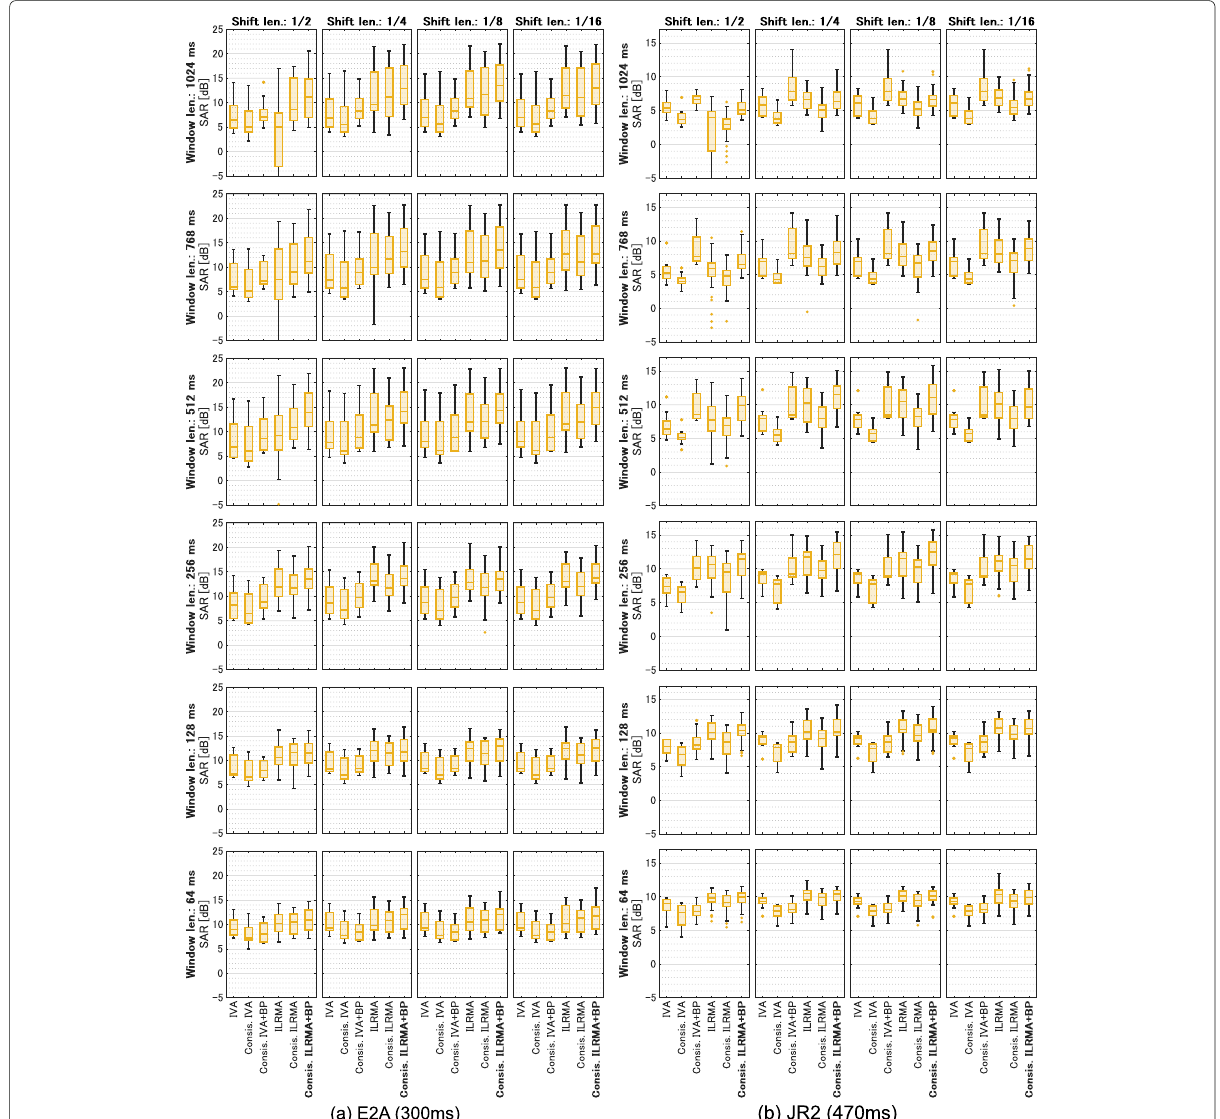
Fig. 22 Average SAR for synthesized music mixtures (music 1–10) with a E2A and b JR2 , where Hann window is used in